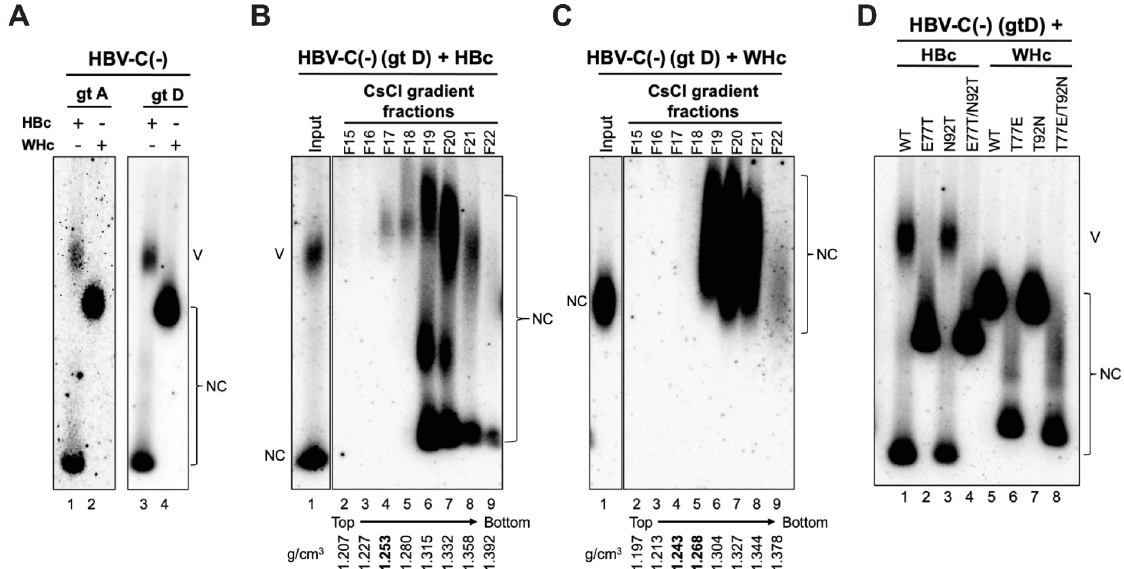
Fig 8. Effects of HBc or WHc on supporting HBV virion secretion. (A) concentrated culture supernatant of HepG2 cells co-transfected with WT HBc or WHc and HBV-C(-) (genotype A or D) was analyzed by agarose gel electrophoresis. HBV DNA in virions or naked capsids was detected by a HBV DNA probe. Concentrated culture supernatant of HepG2 cells co-transfected with WT HBc or WHc along with HBV-C(-) (genotype D) was fractionated by CsCl density gradient ultracentrifugation. The fractions from WT HBc (B) or WT WHc (C) co- transfected culture supernatant was analyzed by agarose gel electrophoresis. HBV DNA in virions or naked capsids was detected by a HBV DNA probe. The density profile of each fraction is indicated at the bottom. The density of HBV virions (1.250 g/cm 3 ) is highlighted in bold. (D) concentrated cell culture supernatant of HepG2 cells co-transfected with HBV-C(-) (genotype D) and WT or mutant HBc or WHc was analyzed by NAGE and DNA in virions or naked capsids was detected by a HBV DNA probe. NC, nucleocapsid; V, virion.